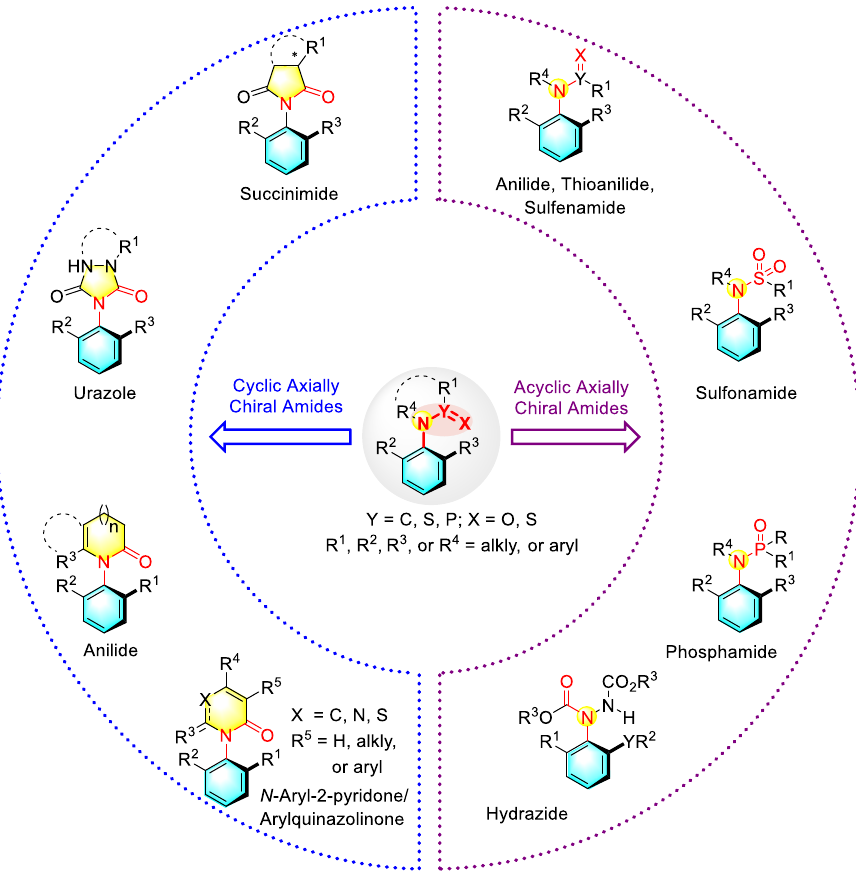
Figure 1. Representative forms of C – N axially chiral amides. * represents a chiral center.